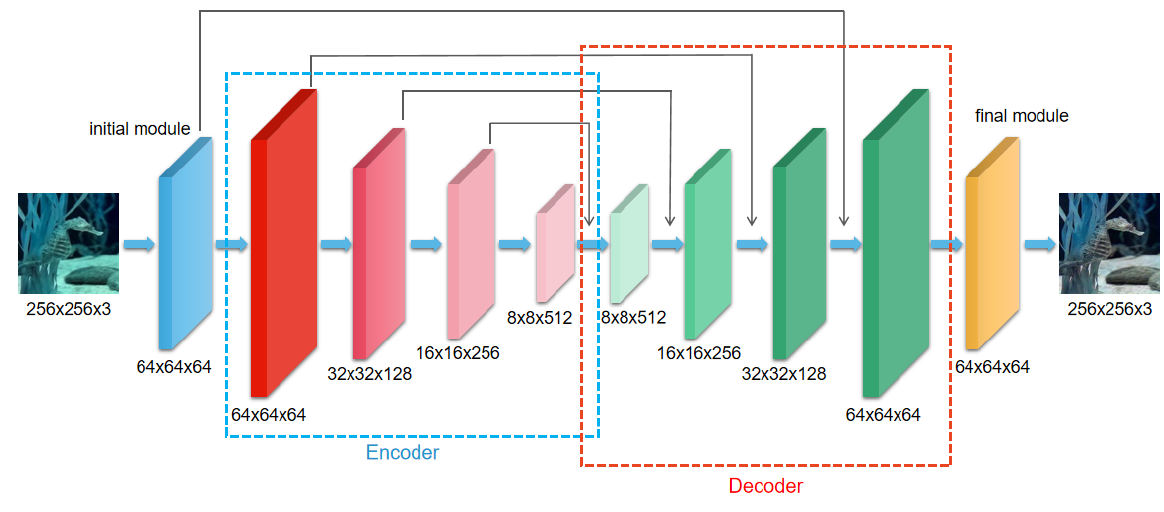
Figure 1. Generator of the